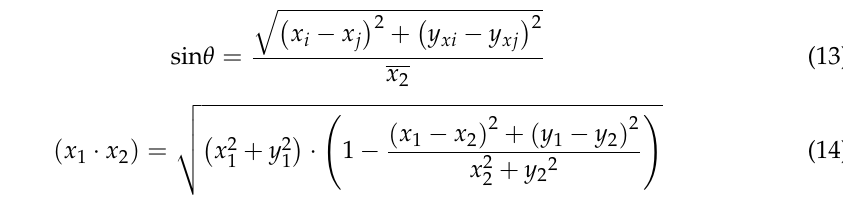
Algorithm 3 SVM Algorithm to Differentiate Benign or Malignant